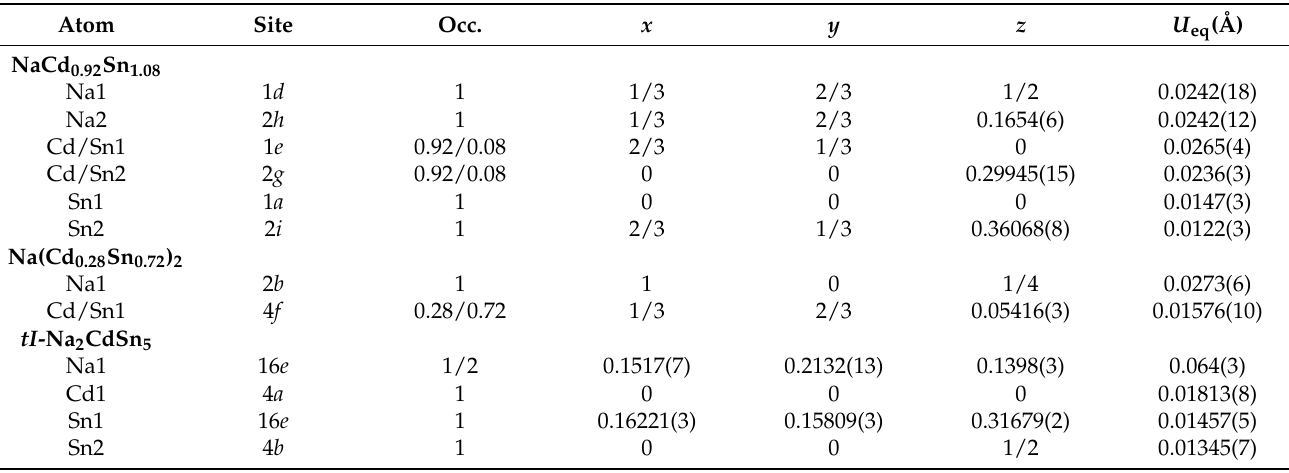
Table 2. Atomic coordinates and equivalent isotropic displacement parameters of NaCd 0.92 Sn 1.08 , Na(Cd 0.28 Sn 0.72 ) 2 , and tI -Na 2 CdSn 5